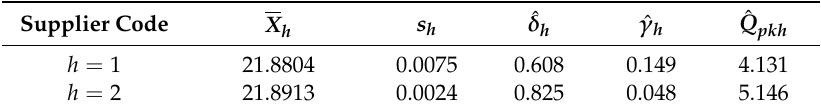
Table 1. Statistics of collected